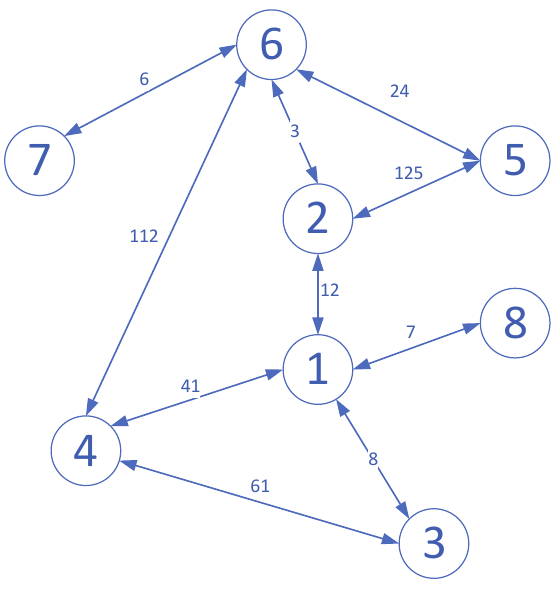
Figure 1. An example of CDN with 8 nodes.